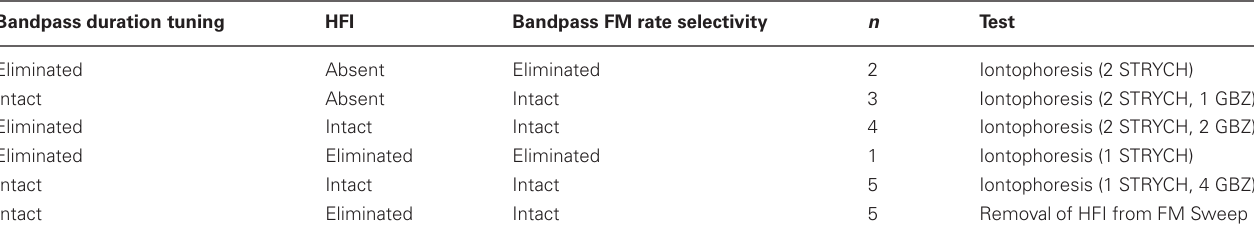
Bandpass duration